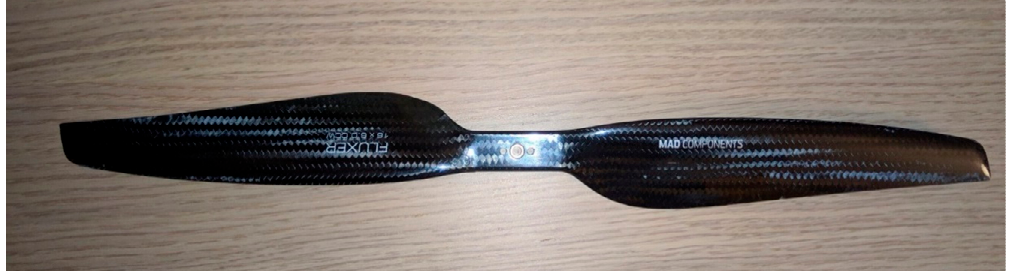
Figure 3. Unmodified propeller (16 × 6).